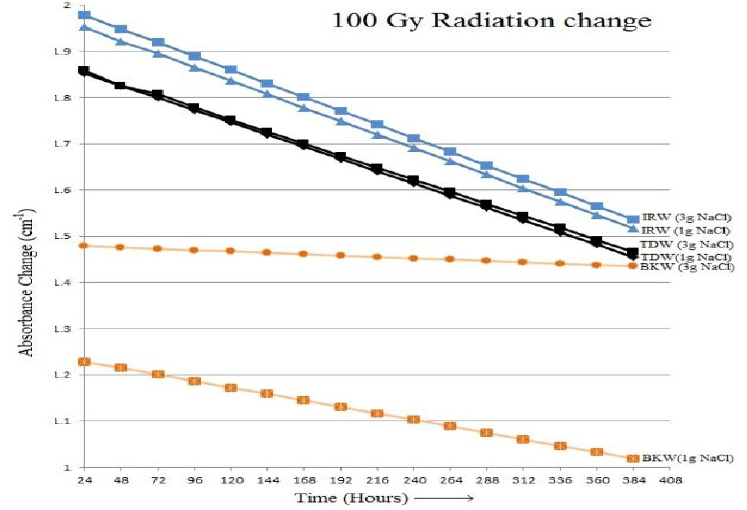
Figure 2: Exposure of dosimeter samples at 100 Gy radiation